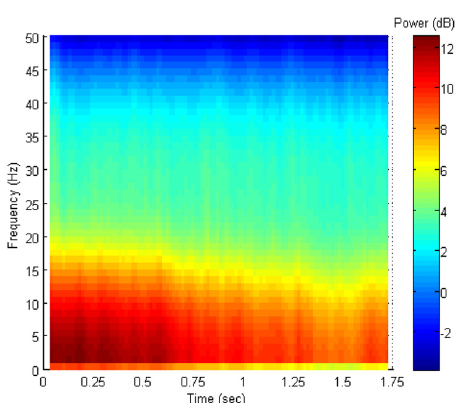
Figure 6. Average